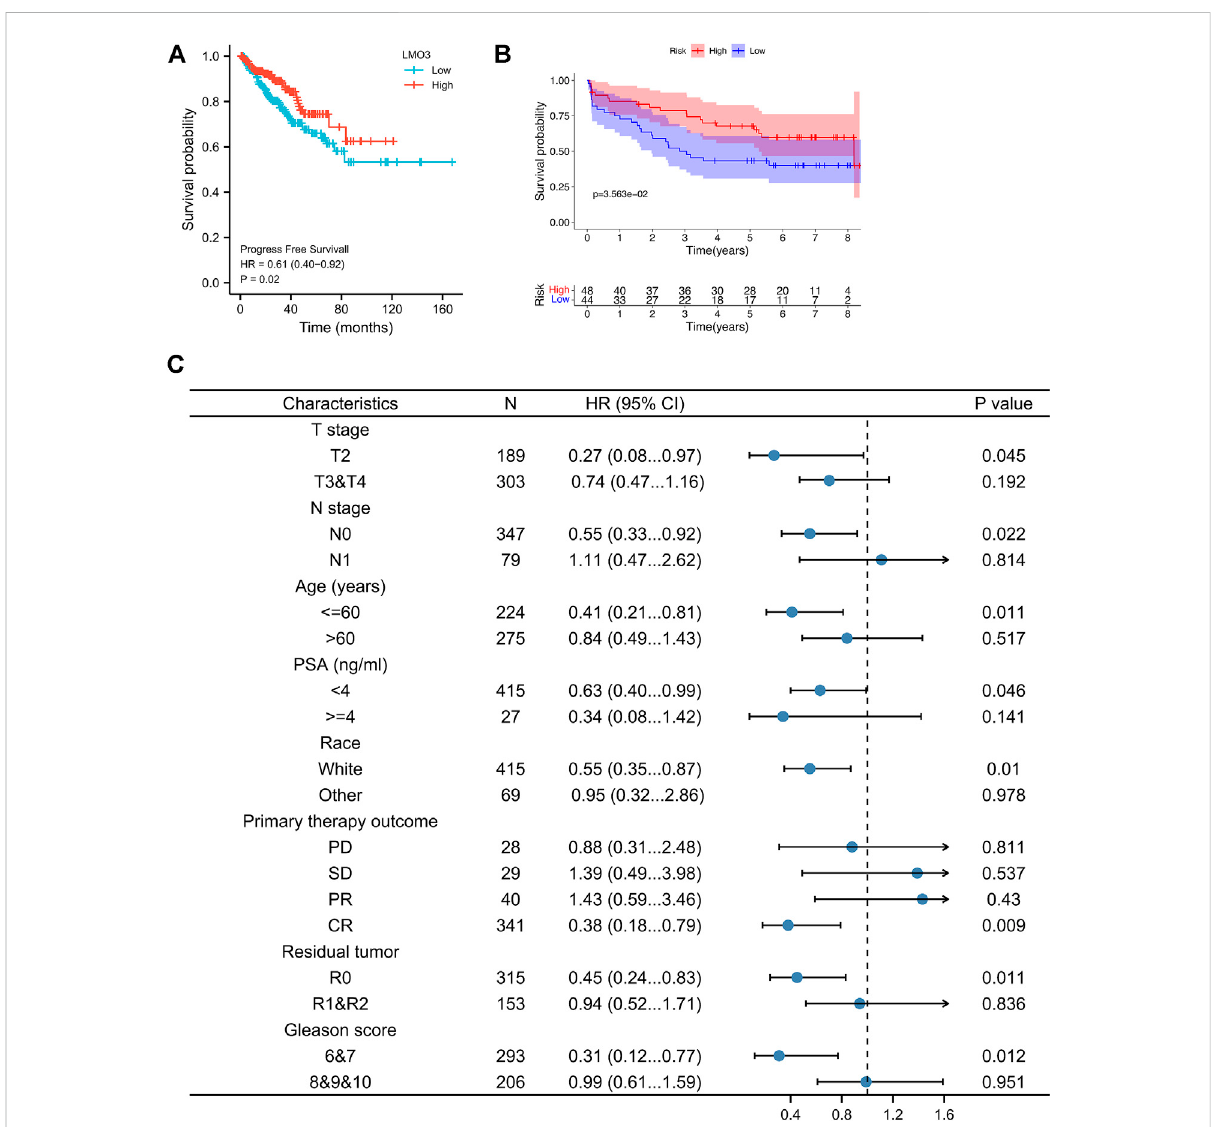
FIGURE 3 SurvivalcurveevaluatingtheprognosticvalueofLMO3. (A) SurvivalcurvesareshownforPFS. (B) SurvivalcurvesusingtheGSE70769cohortare shown for DFS. (C) Forest plot showing the correlation between LMO3 expression and clinical parameters in PRAD